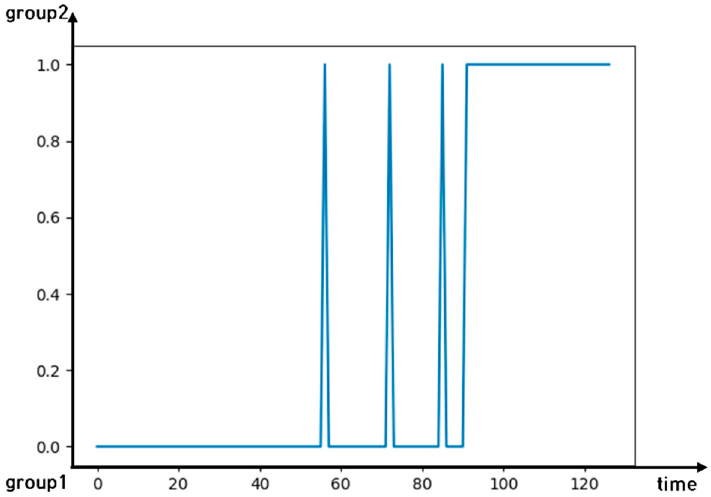
Figure 21. An instance of a participant’s k-Means results.